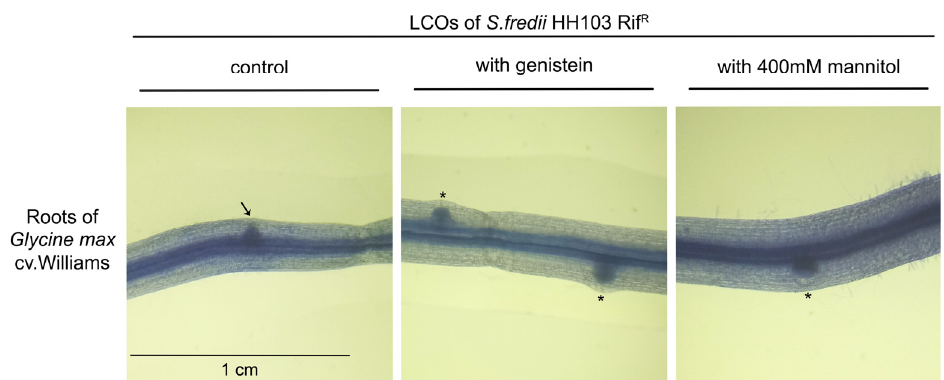
Figure 3. Biological activity assay of the NFs purified from S. fredii HH103 cultures grown in B − medium in the absence (control) or presence of 3.7 µM genistein or 400 mM mannitol applied to soybean roots. Nodule primordia (circular shape) are denoted by asterisks, whereas an arrow marks an emerging lateral root (spiky shape).